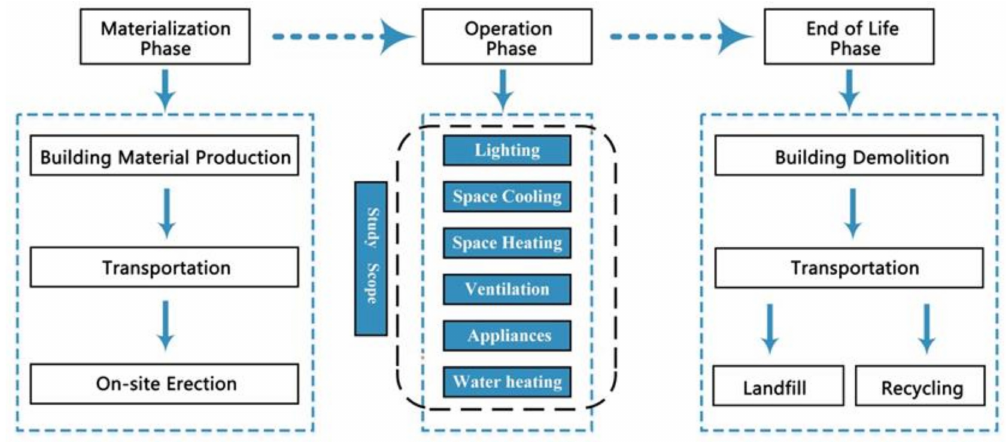
Figure 6. A Flowchart of the life-cycle assessment and the study